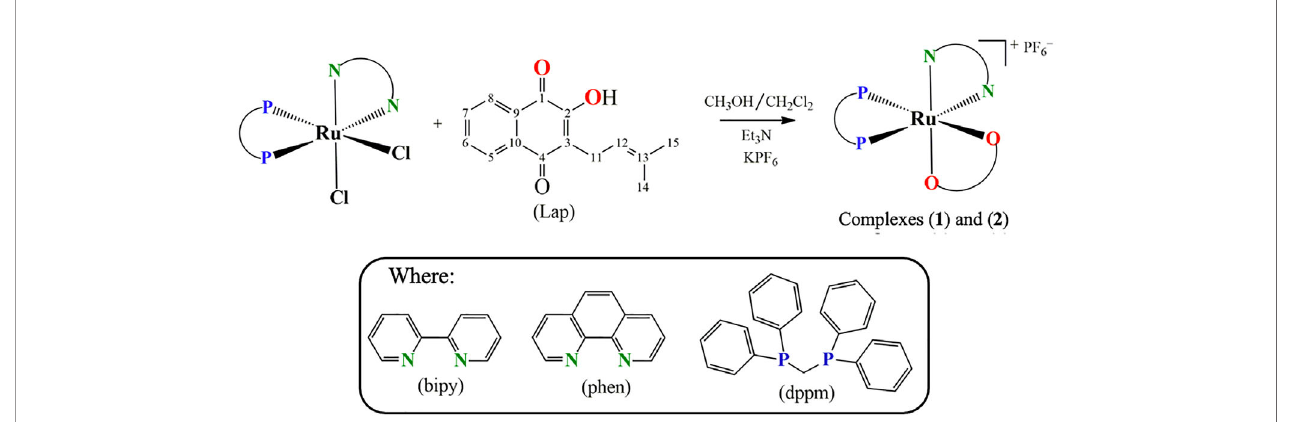
FIGURE 1 | Route for the synthesis of complexes [Ru(Lap)(dppm)(bipy)]PF 6 (1) and [Ru(Lap)(dppm)(phen)]PF 6 (2)